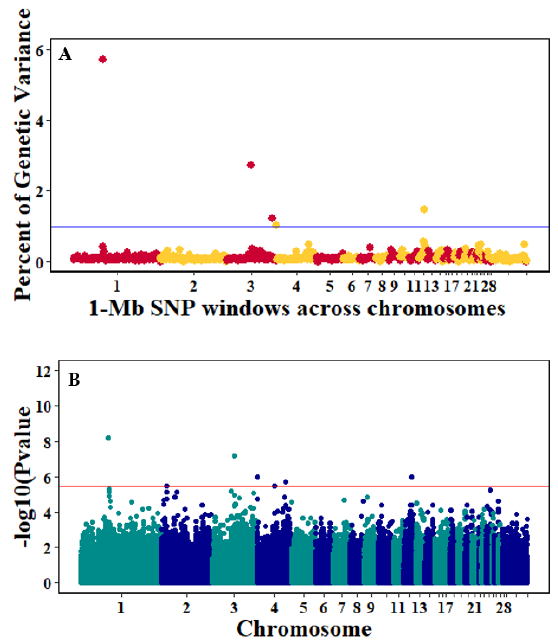
Figure 8. Manhattan plots showing the genome-wide association results for viral clearance using Bayes-B and single-SNP analyses. ( A ) Bayes-B results show the percent of genetic variance explained by 1-Megabase (1-Mb) nonoverlapping windows of SNPs across chromosomes. ( B ) Single-SNP results show the − log 10 ( p -value) of ordered SNPs across the chromosomes. The blue and red lines indicate genome-wide significance at 1% genetic variance and 20% suggestive adjusted Bonferroni correction, respectively.